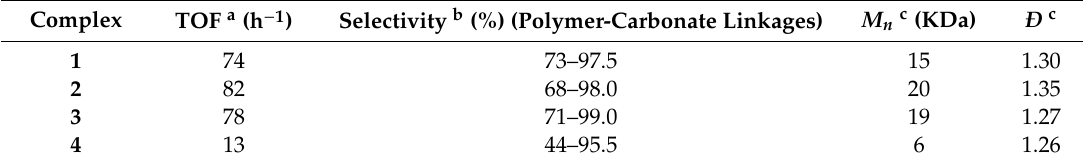
Table 1. Complexes 1–4 in the copolymerization of vinylcyclohexeneoxide (VCHO) and CO 2 [59].